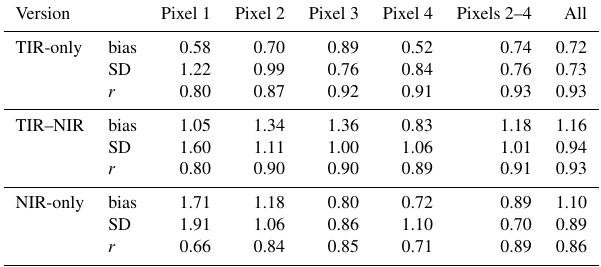
Table 5. Validation results for each pixel over land scenes at Lauder. Bias and standard deviation (SD) units are 10 17 moleccm − 2